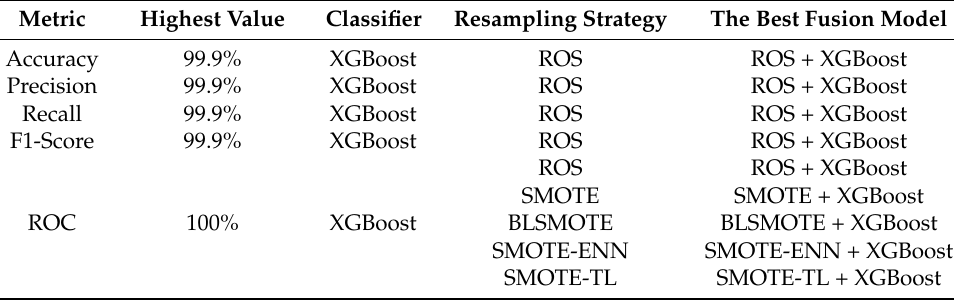
Table 8. Overall performance of model